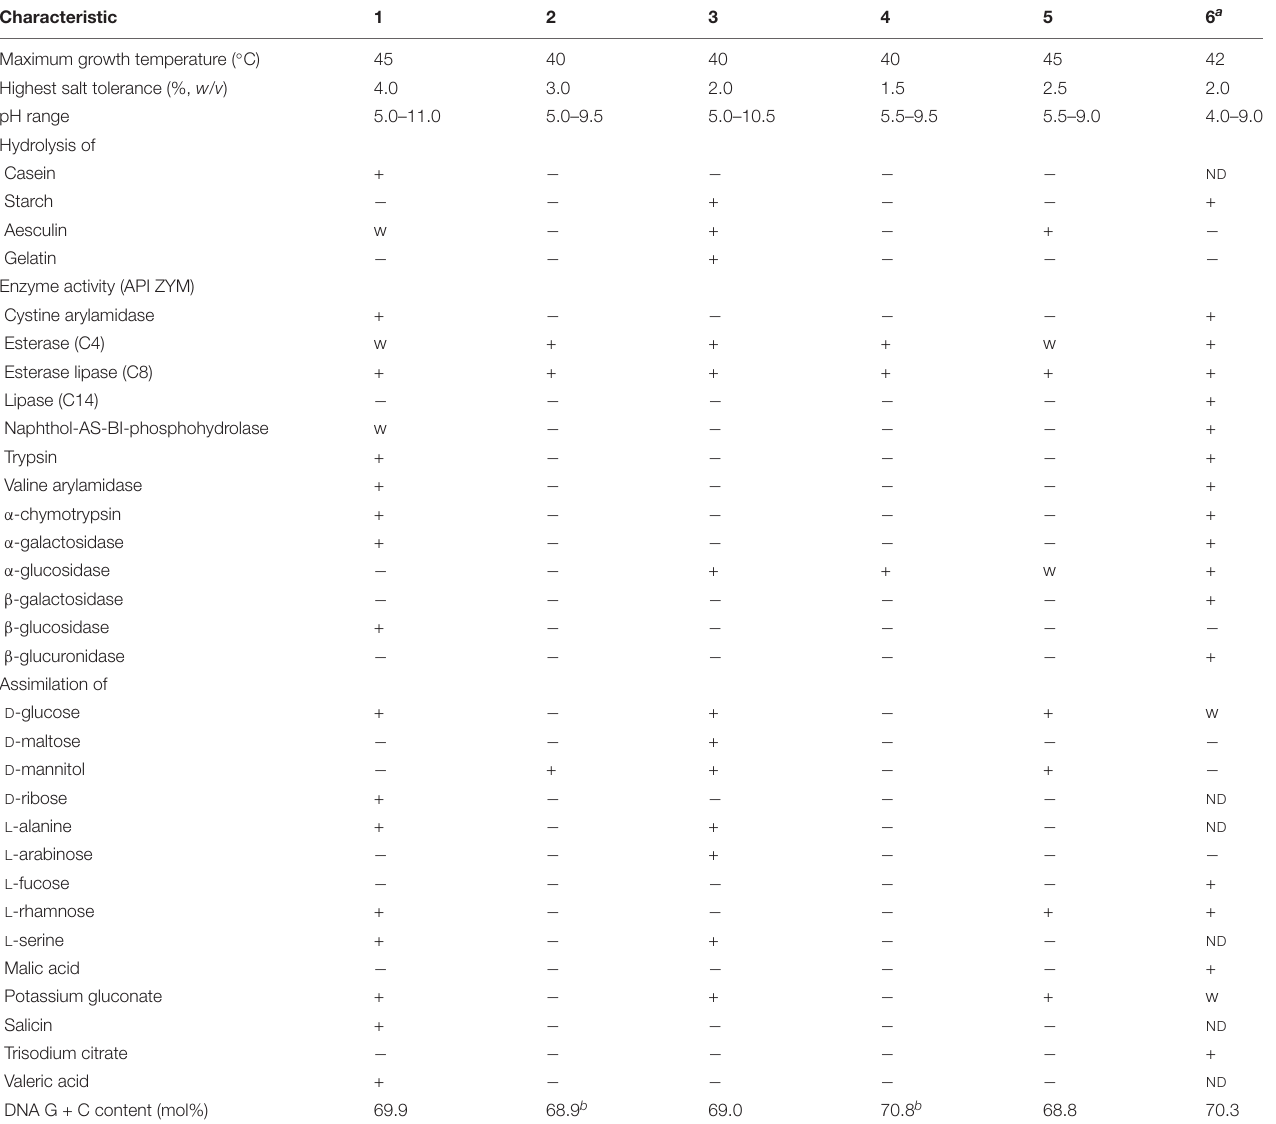
TABLE 2 | Phenotypic characteristics that differentiate strain G-1-1-14 T from the type strains of the genus Azohydromonas .